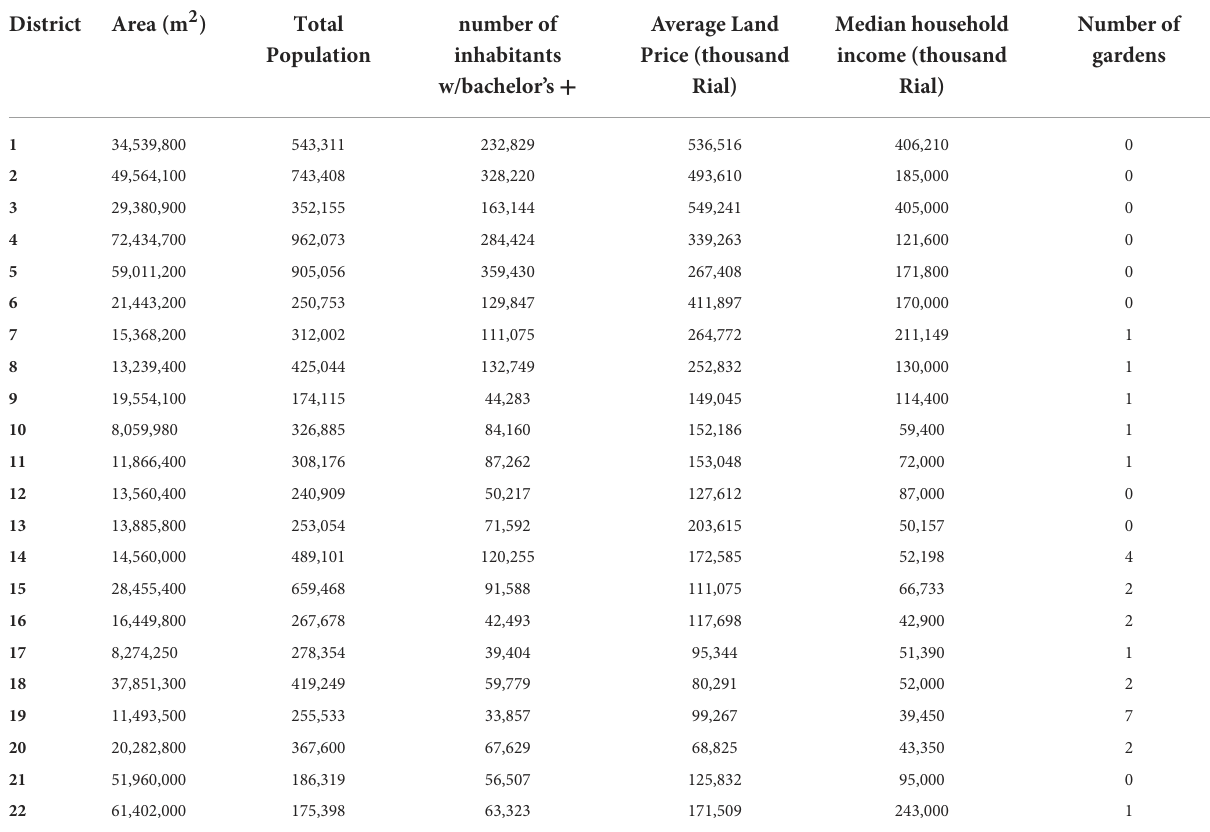
TABLE 2 Socio-economic characteristics of districts in Tehran. District